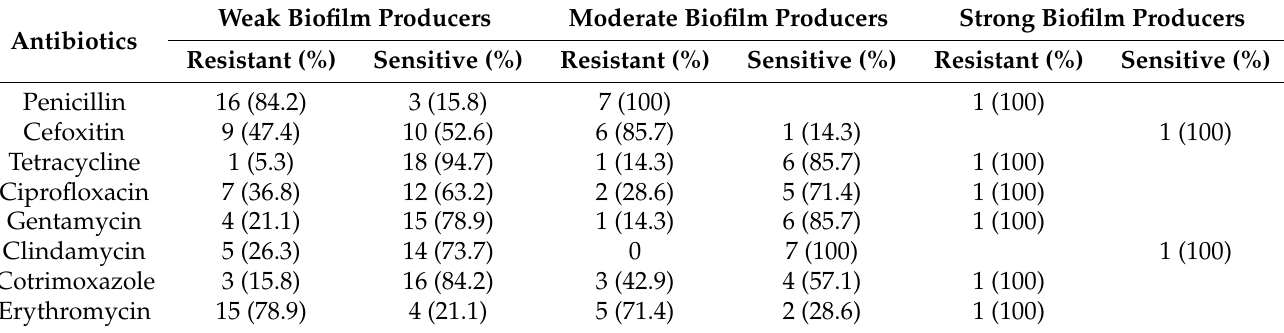
Table 5. Antibiotic susceptibility pattern among biofilm producers.